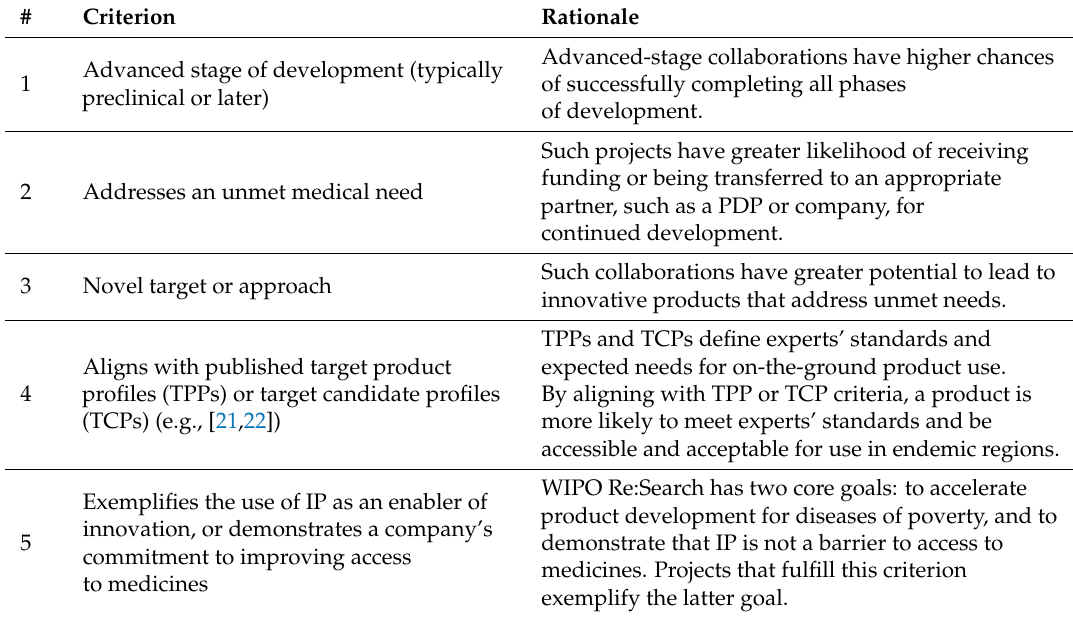
Table 3. Targeted collaboration criteria. BVGH’s partnering process emphasizes development of collaborations that meet critical healthcare needs in LMICs and are likely to result in products that reach